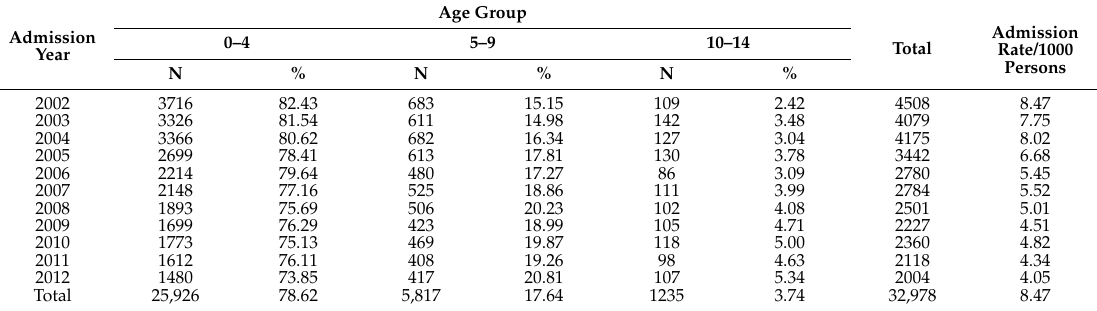
Figure 1. Rate of asthma-related hospitalizations in children and adolescents aged 0–14 years in Belo Horizonte, Minas Gerais, Brazil, by gender, 2002–2012. Asthma-related hospitalization rates were significantly different ( p ≤ 0.05) across age groups Table 1. Frequency of asthma hospitalizations by age group in children and adolescents aged 0–14 years and there was a decreasing trend in hospitalization rates over the 11-year study period. Specifically, from 2002 to 2012 in Belo Horizonte, Minas Gerais, hospitalization frequency declined by approximately 55% and 36% in the 0 ‒ 4 and 5 ‒ 9 year age